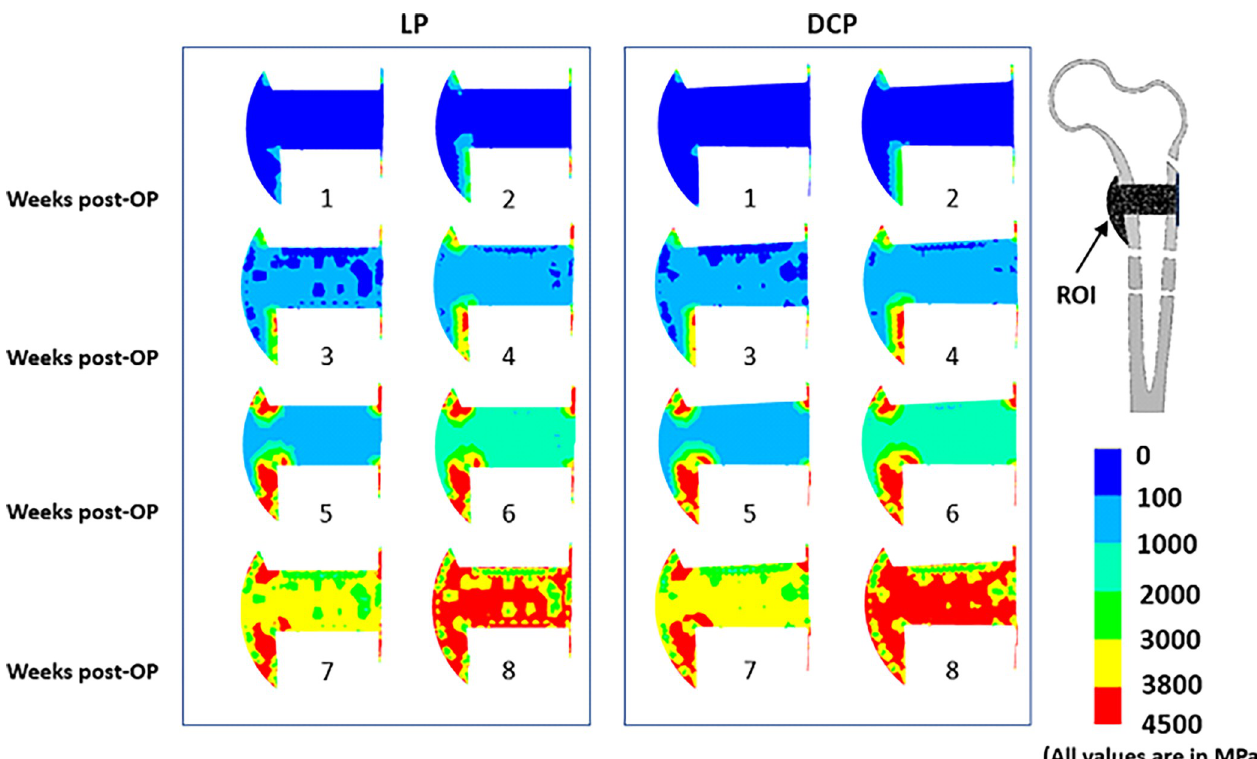
Fig 8. Post-operative distribution of modulus (unit MPa) in the ROI from week 1–8 for (a) LP and (b) DCP. It may be noted that the modulus gives a measure of mechanical strength of the region (i.e. higher the modulus, stronger is the region).